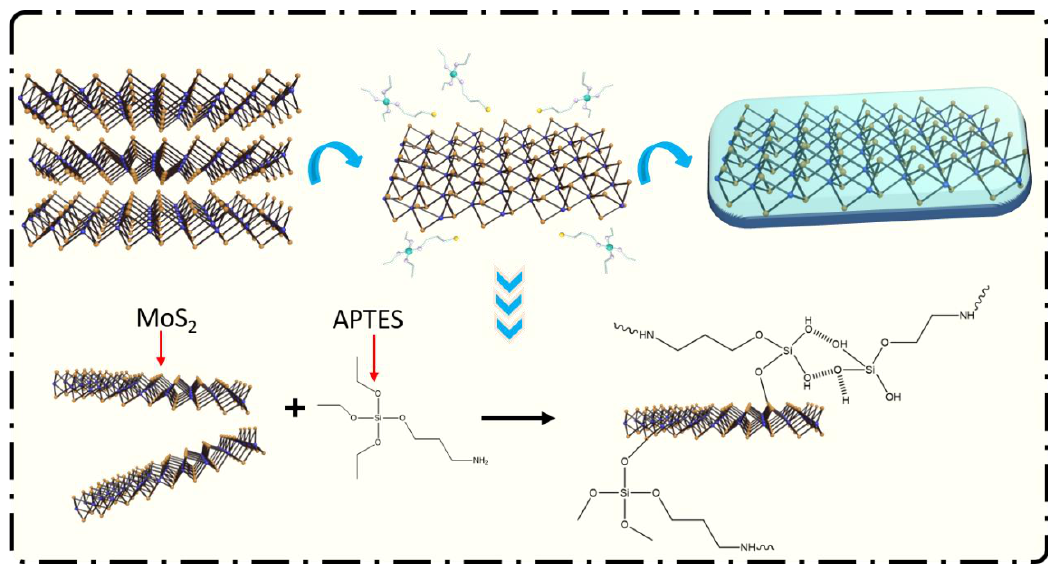
Figure 1. Schematic of the synthesis procedure of MoS 2 -3-aminopropyltriethoxysilane (APTES) via APTES hydrolysis.